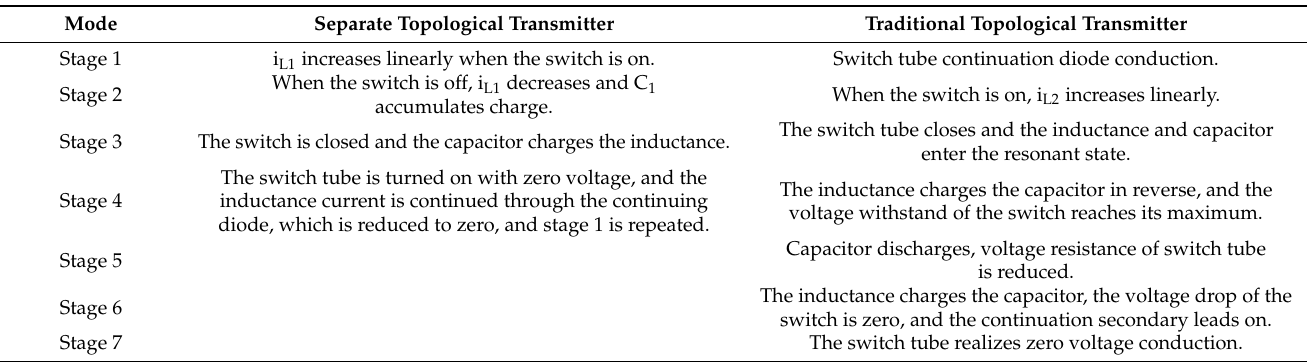
Table 1. Modal analysis of the transmitter.